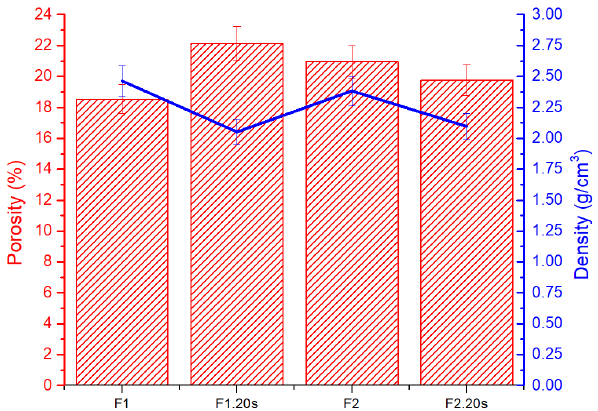
Figure 7. Porosity and density vs. temperature for all forsterite samples.